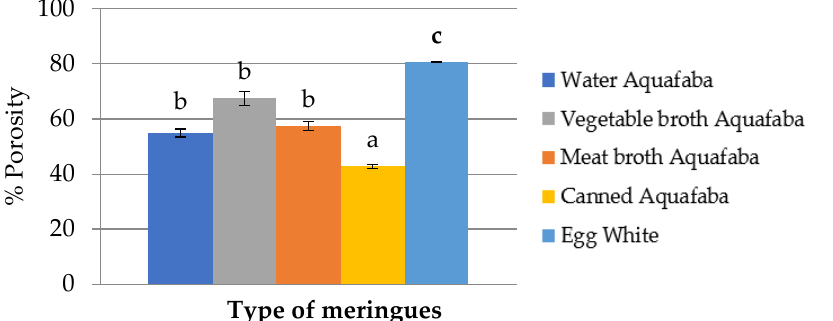
Figure 3. Mean values of alveoli degree of meringues, expressed as % of porosity, made with four types of Pedrosillano chickpea aquafaba and egg white. a–c Means with different superscripts showed significant differences ( p < 0.05).